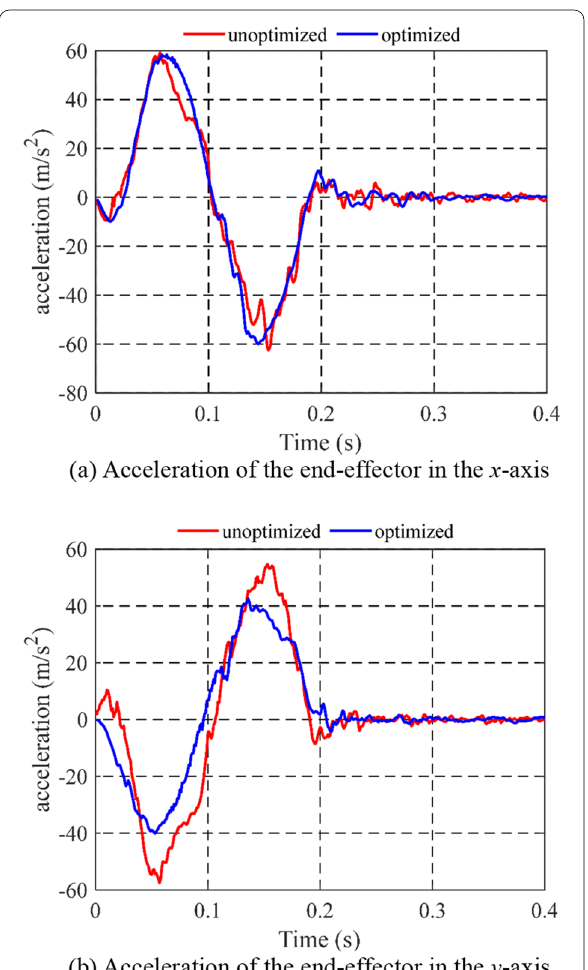
Figure 12 Acceleration of the end-effector in the x- and y